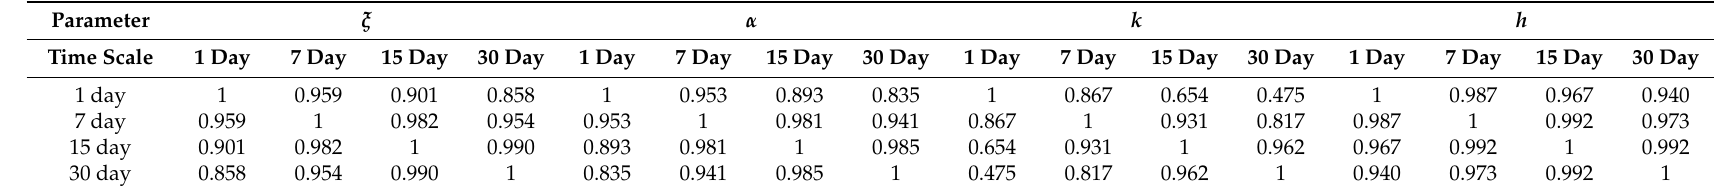
Table 1. Linear correlation coefficients between four KAP parameters at different time